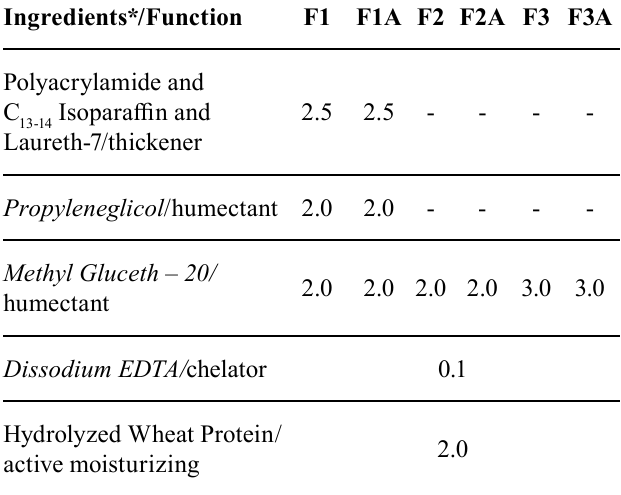
TABLE I – Q ualitative and quantitative composition (%